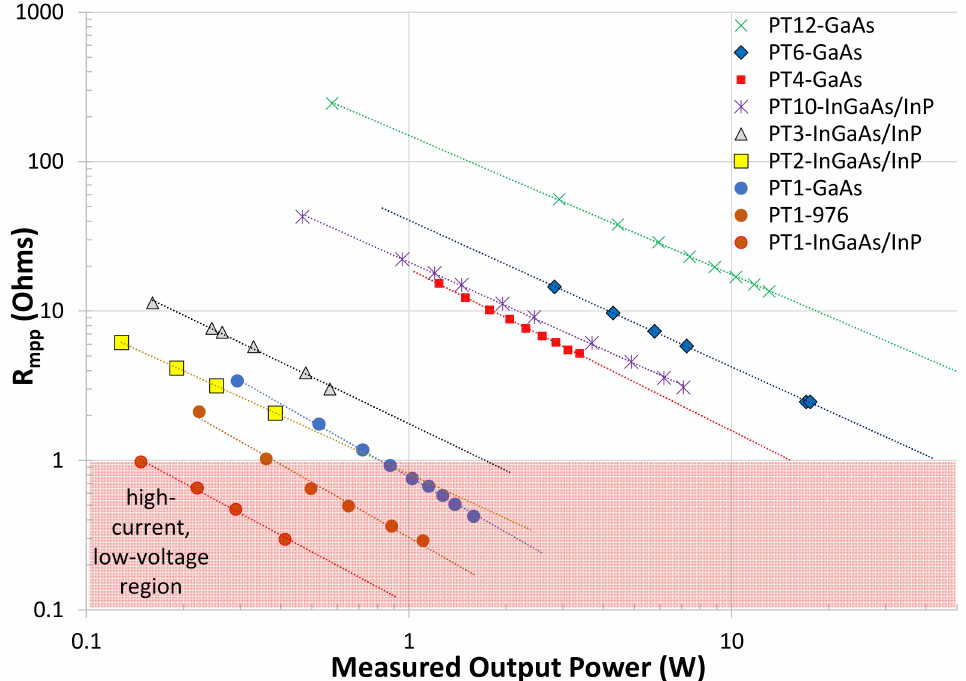
Figure 5. The measured optimal load (R mpp = V mpp /I mpp ) as a function of the output power obtained with various OPC designs. As indicated in the caption, results are measured for the follow- ing OPC designs: single junctions from the material systems of InGaAs/InP (“PT1-InGaAs/InP”) at ~1470 nm [37], of InGaAs/GaAs (“PT1-976”) at ~976 nm [37], and of GaAs (“PT1-GaAs”) at ~808 nm [37,57]; from multijunctions from the InGaAs/InP material system, “PTN-InGaAs/InP”, with N = 2, 3, and 10, corresponding to the number of InGaAs subcells [this study]; and from multi- junctions from the GaAs material system, “PTN-GaAs”, with N = 4, 6, and 12, corresponding to the number of GaAs subcells [37,41]. The area of low voltage and high current is shown in pink and is less desirable for practical